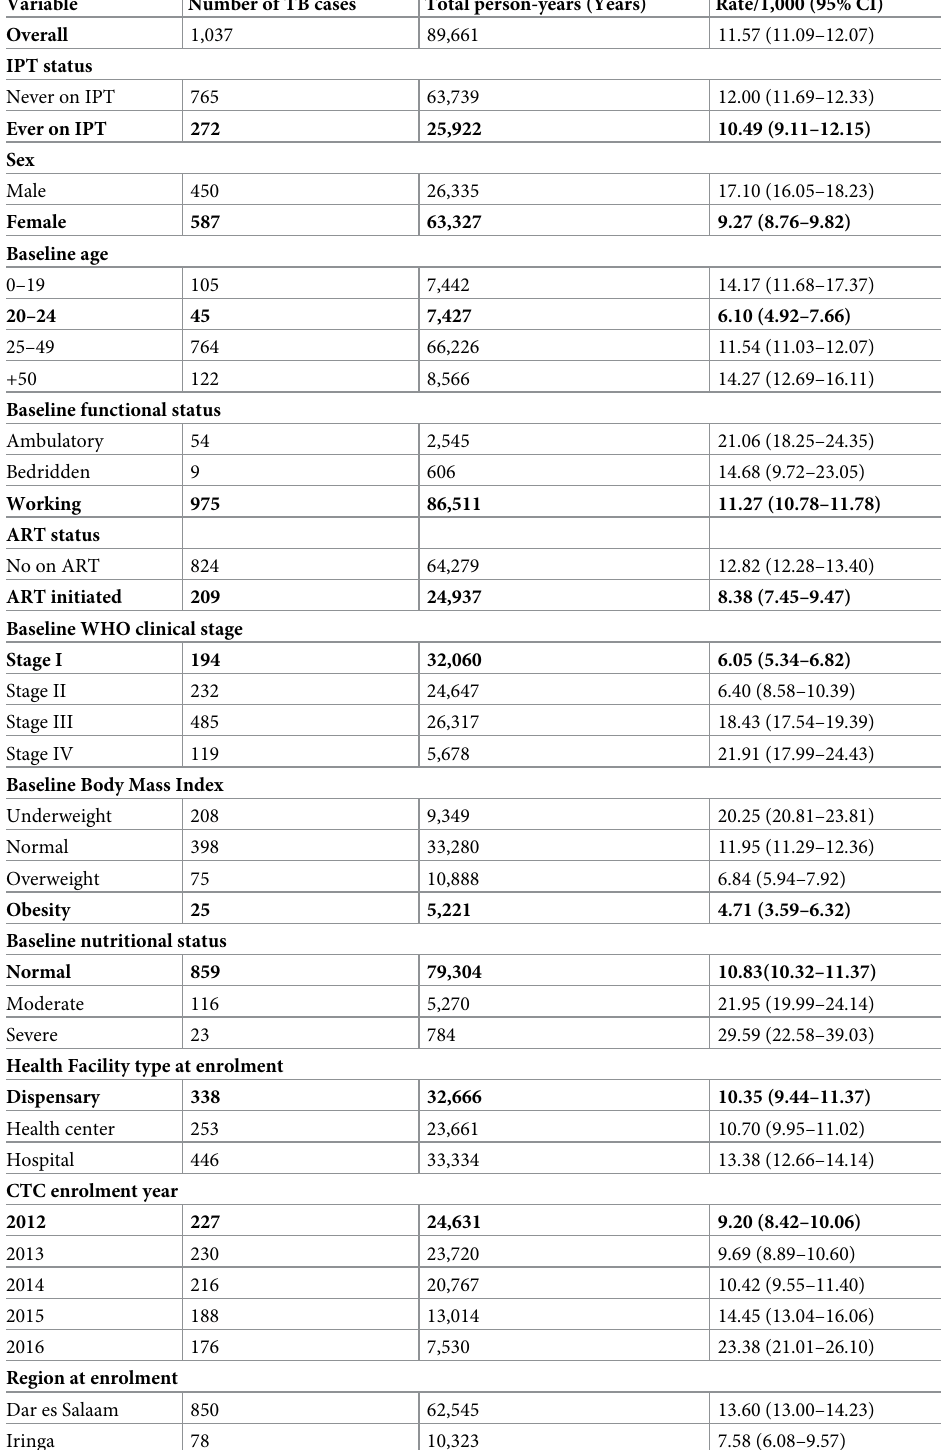
Table 3. The incidence of TB cases, total person-year and TB rates among 24,800 PLHIV who received IPT and a weighted sample of those who did not receive